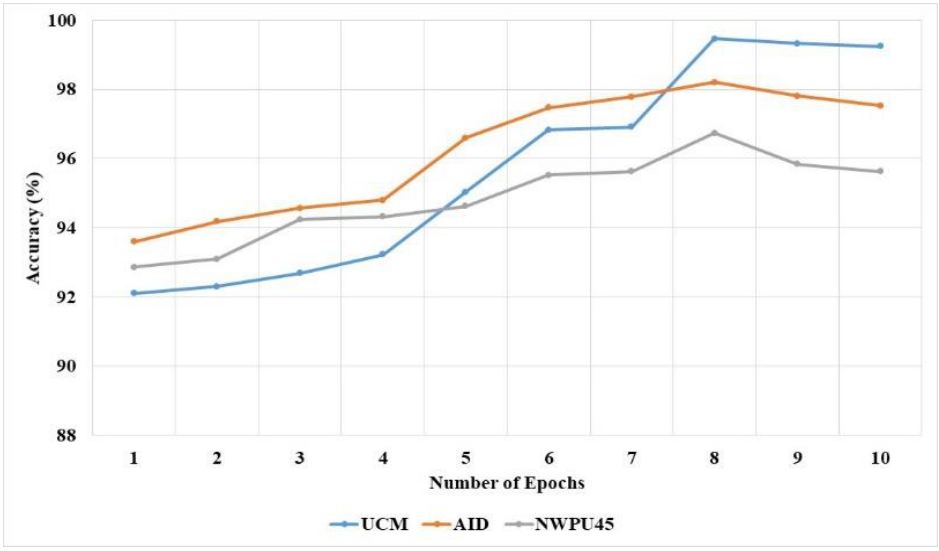
Figure 11. GM-SMO method accuracy vs. number of epochs in scene classification.